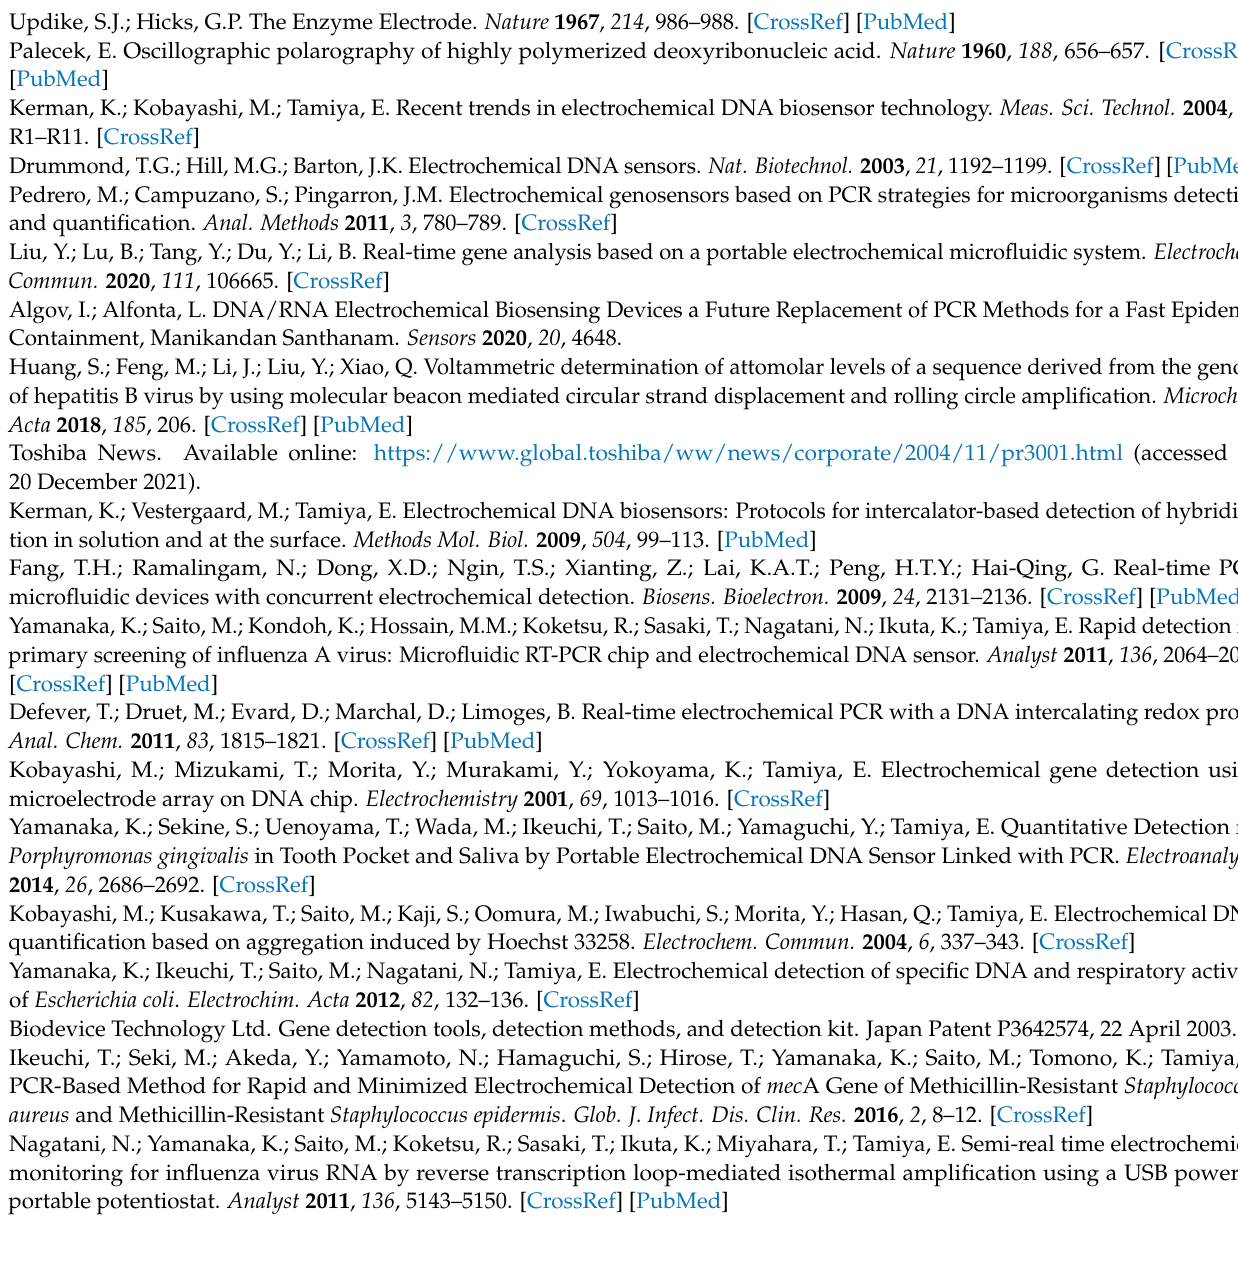
Table S4. Electrochemical results with real human samples